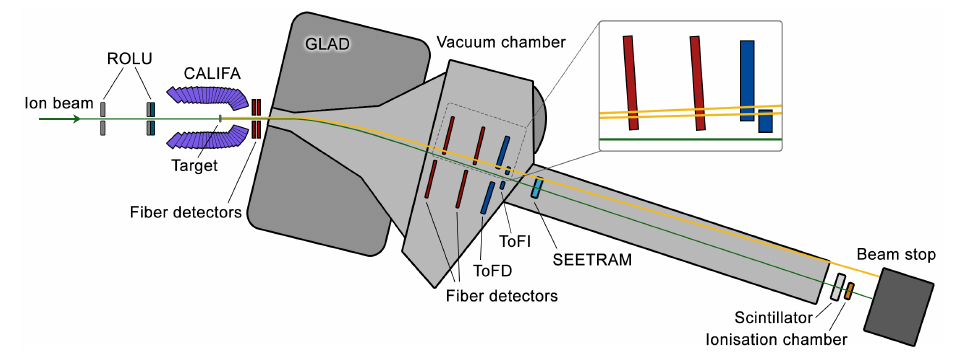
Figure 1. Sketch of the experimental setup at R 3 B as it was used for the Coulomb dissociation of 16 O. Two active collimators, ROLU, in front of the target cut the beam dimension by creating a veto focus and help to center the ion beam on the target. γ -rays from excited 12 C are measured in the CALIFA calorimeter. For tracking of the fragments two fiber detectors in front of the magnet GLAD measure the x- and y-position. Two pairs of fiber detectors downstream from GLAD measure the x-position. The time-of-flight walls ToFD and ToFI allow to extract the charge of the fragments, based on their energy loss. All tracking detectors had slits or a hole and were mounted on drives to allow the unreacted beam to pass without damaging the detectors or causing high dead time by its high intensity. A secondary electron transmission monitor (SEETRAM) detector as well as a scintillator and an ionization chamber measured the beam